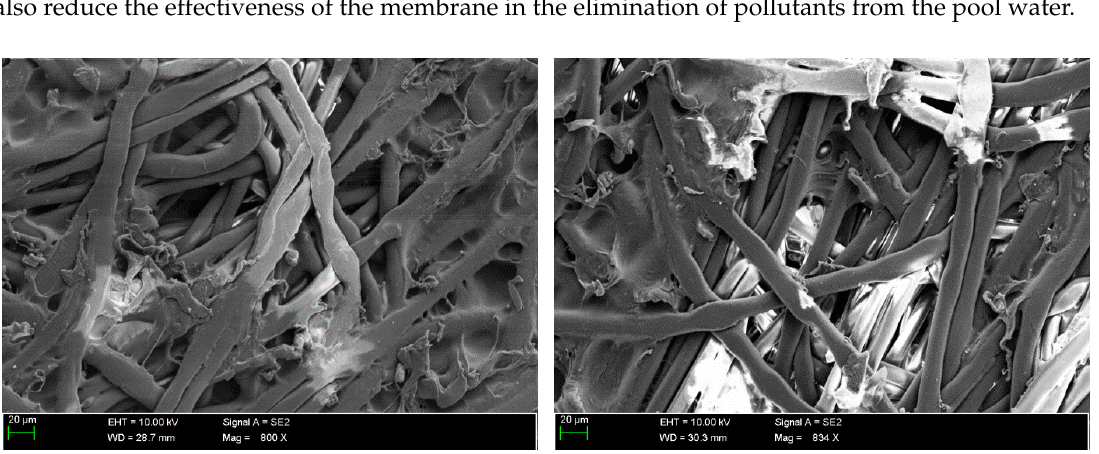
Figure 5. SEM micrographs of the membrane after filtration of swimming pool water.